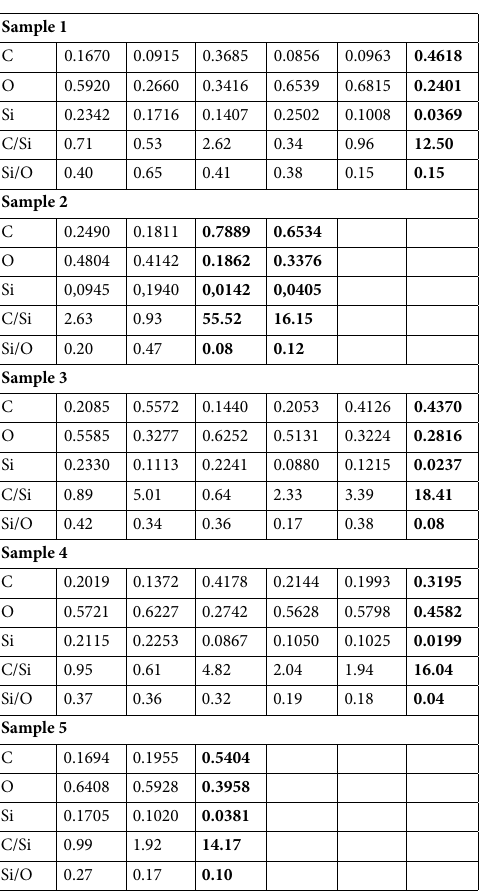
Table 3. Molar ratios of elements identified by SEM–EDS spectroscopy for areas with archaeological residue (bitumen) and fresh areas (without the residue) on samples 1–5. Areas with bitumen residue are in